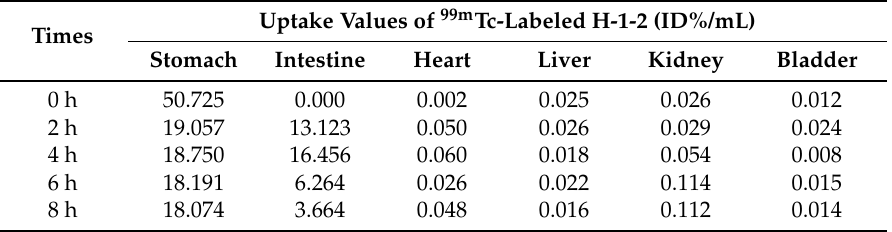
Table 4. Different organ uptake values of 99m Tc-labeled H-1-2, taken orally, in rats ( n = 3). Times